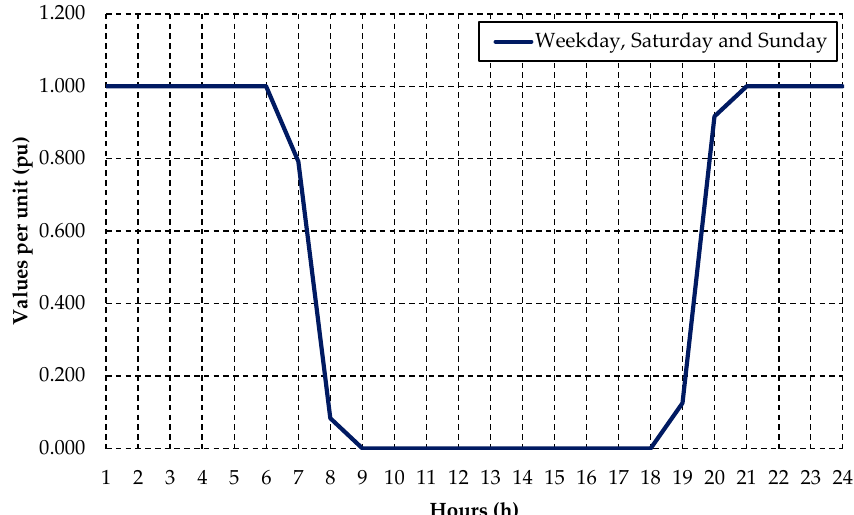
Figure 5. Typology of the daily load profile for an industrial customer. Source: The authors.